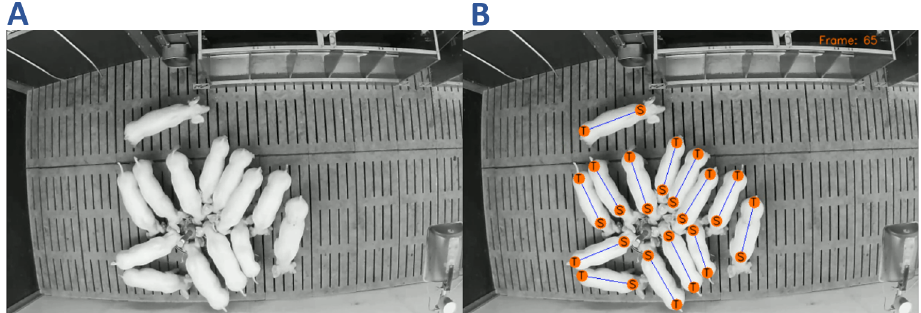
Figure 5. Example of the CNN pig detection showing the original frame ( A ) and the detected shoulder and tail points ( B ). The frame shows a feeding situation in which several pigs are in close proximity to each other. Each pig is marked by highlighting the corresponding shoulder and tail points as well as the connection